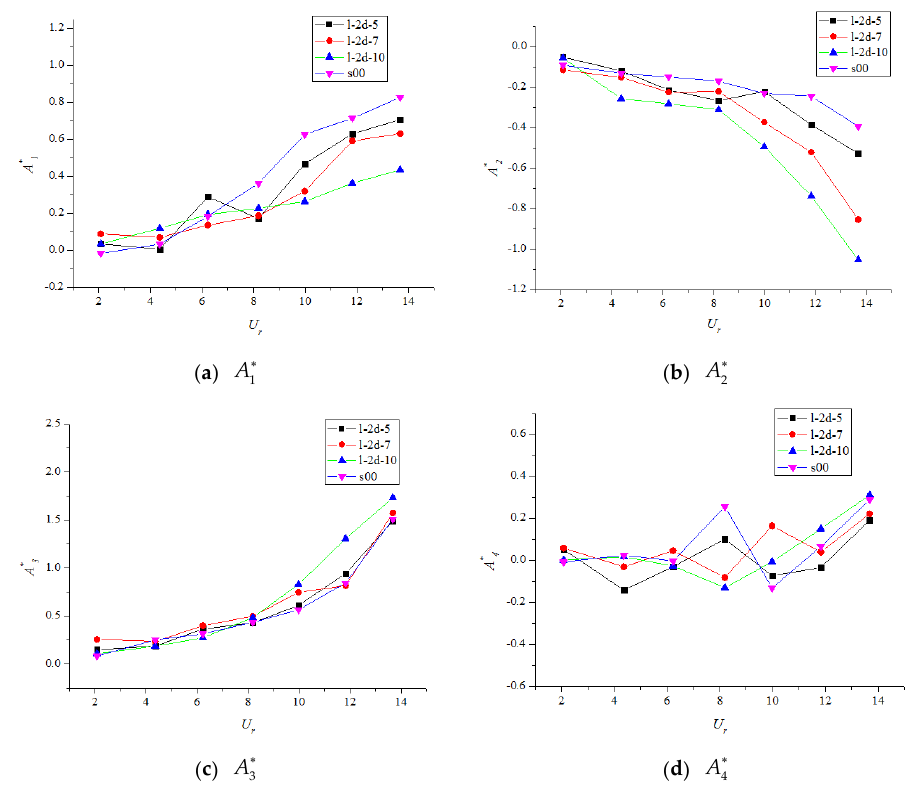
A i ( i = 1 − 4) for test cases with different suction intervals.